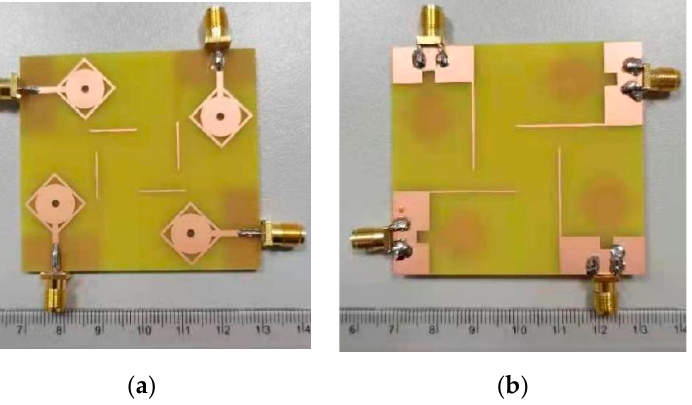
Figure 10. Fabricated prototype of MIMO antenna. ( a ) View from the top and ( b ) view from the bottom.